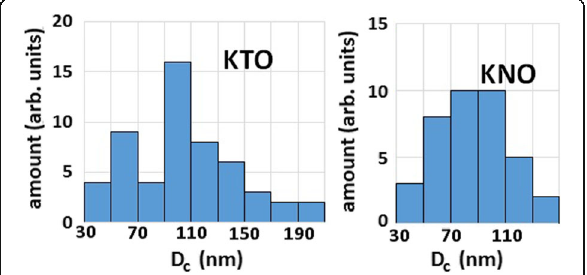
Fig. 5 The size distribution of crystallites in KTaO 3 and KNbO 3